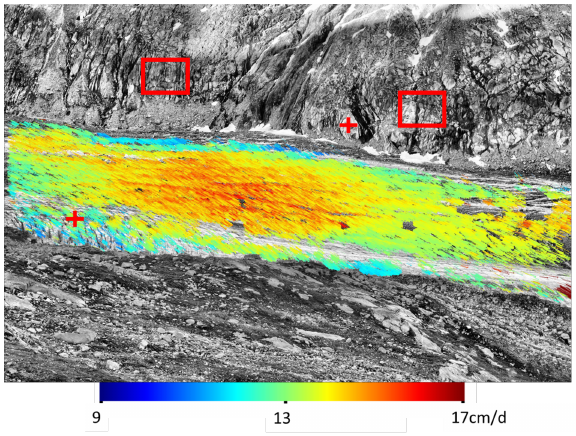
Figure 12. Surface velocity between images taken the 25/07/2019 and the 11/08/2019, calculated with our methods. The red crosses indicate the location of the depth map analysis presented in Figure 8 and the red rectangles the position of the registration analysis presented in Figure 5